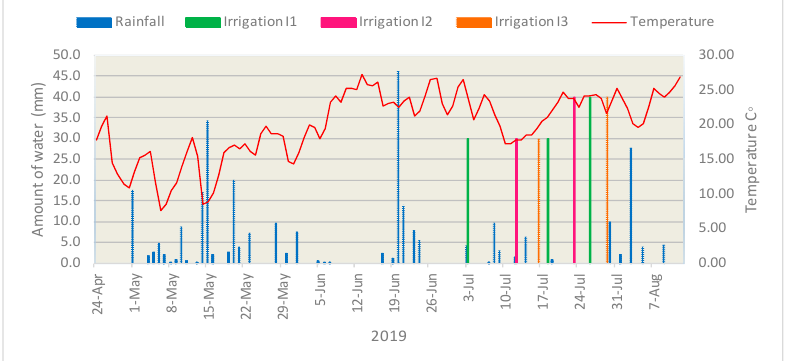
Figure 2. Irrigation water applied, mean daily air temperature (°C), and daily precipitation (mm) in 2018.